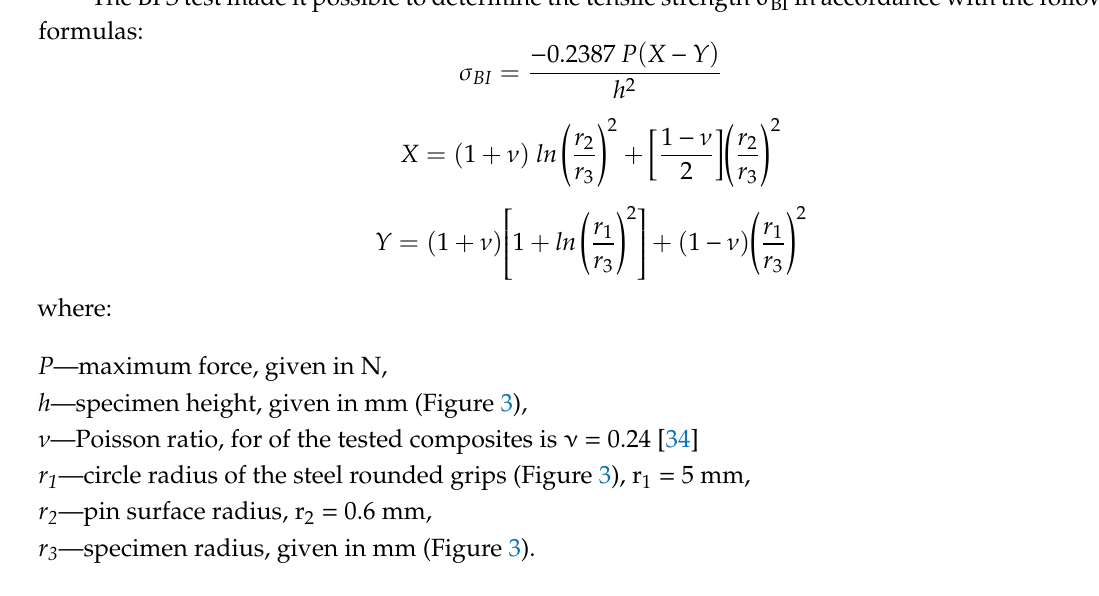
Table 2. Descriptive statistics of the results obtained in the BFS test.